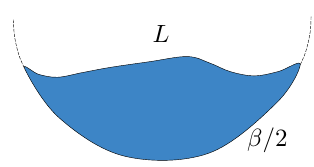
Figure 7 . Depiction of the geometry creating the Hartle-Hawking state Ψ β ( L ) . The state is labeled by a parameter β that gives the proper length of the boundary segment preparing the state. The constant time slice is labeled by L , which is related to the geodesic distance along the